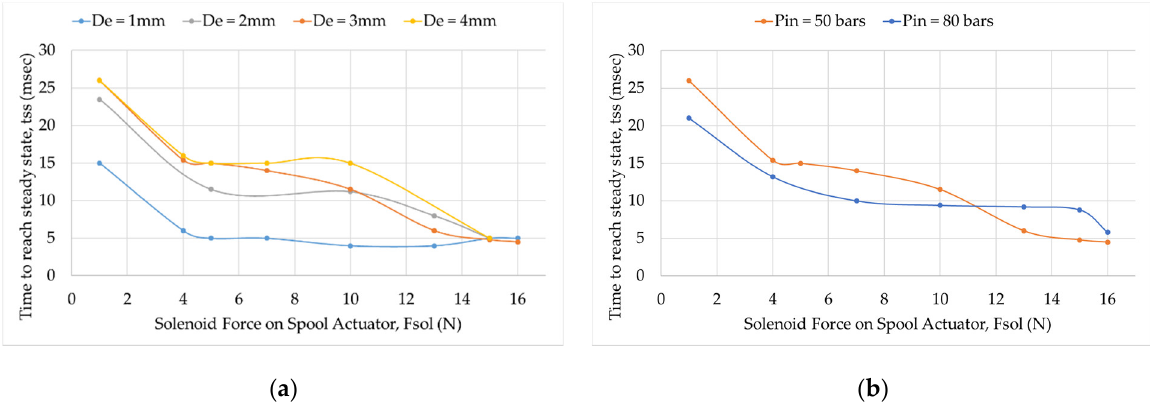
Figure 11. Comparison of system’s agility; ( a ) for different outlet openings; ( b ) for two different inlet pressure settings while keeping De = 3 mm.